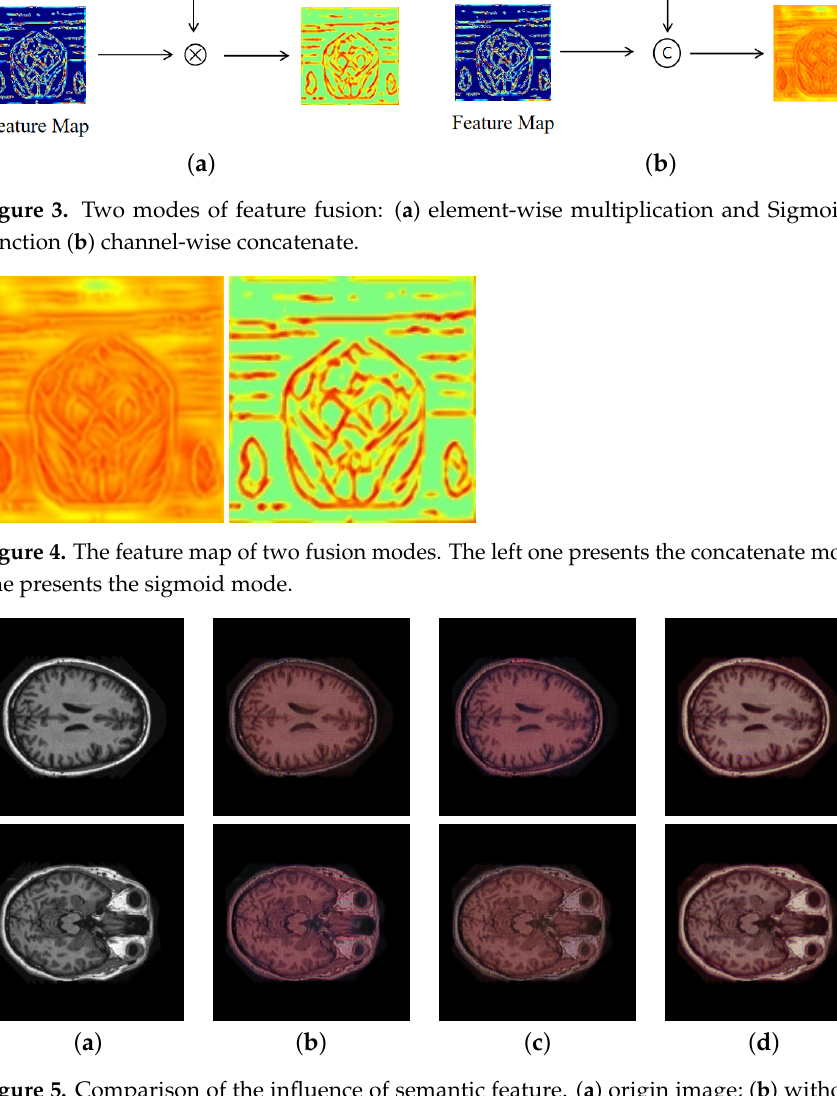
Figure 5. Comparison of the influence of semantic feature. ( a ) origin image; ( b ) without semantic information; ( c ) with semantic information in concatenate mode; ( d ) with semantic information in sigmoid mode. Table 1. Comparison of Concatenate and Sigmoid